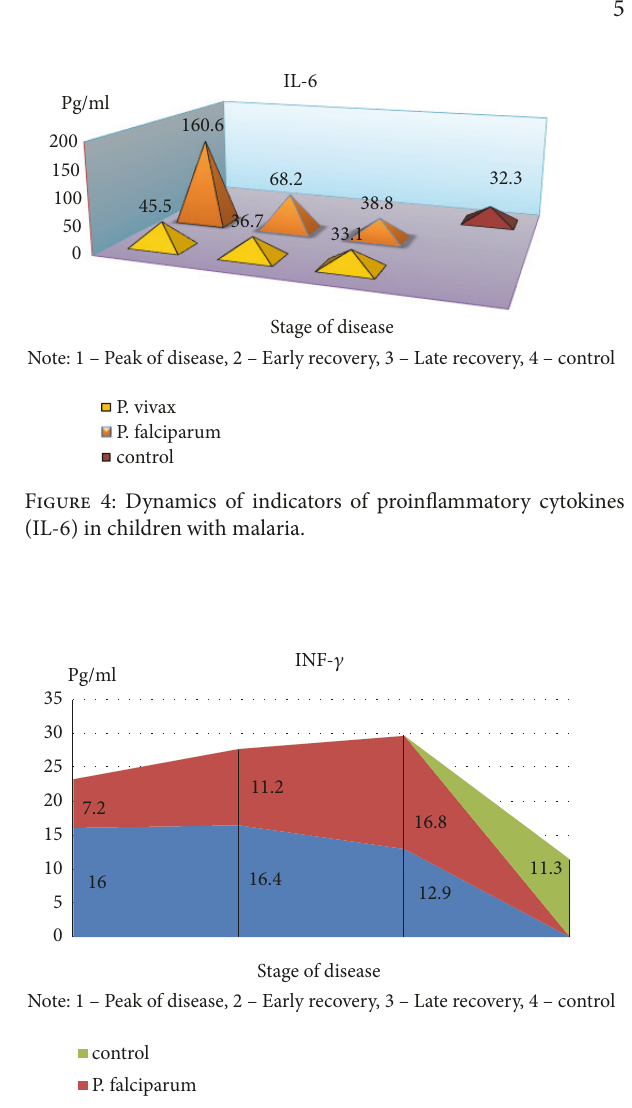
Figure 5: Dynamics of indicators of proinflammatory cytokines antagonists (IFN- 𝛾 ) in children with malaria.